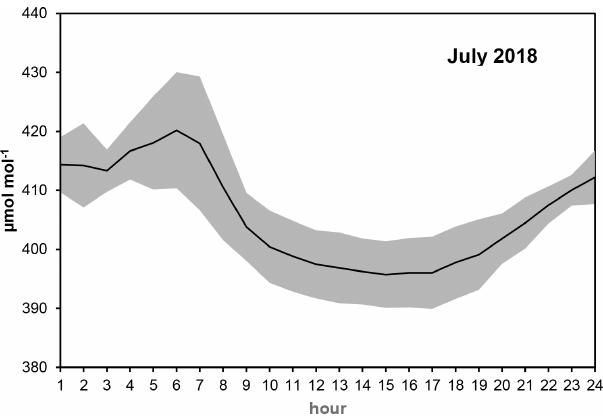
Figure 7. The average diurnal variation of carbon dioxide concen- tration at Hegyhátsál tall-tower site (82m above the ground) in July, when the daily amplitude is the highest. The gray zone indicates the 1 σ